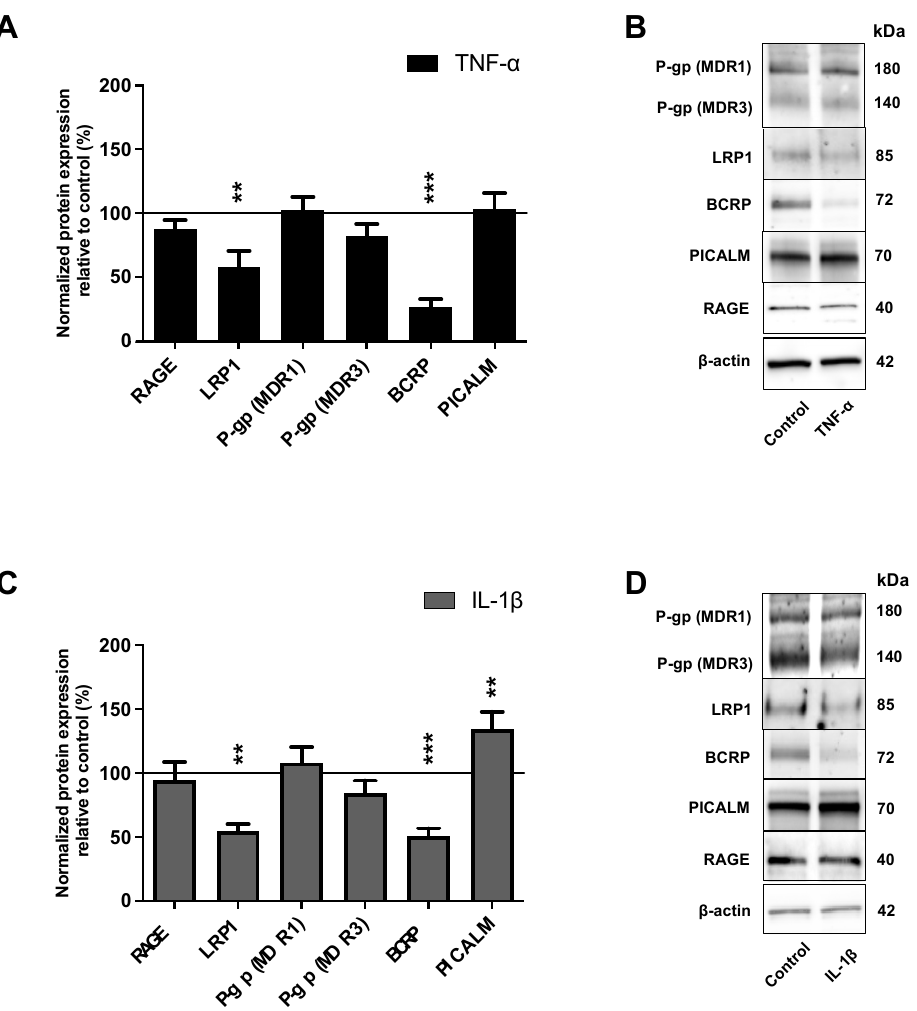
Figure 4. Impacts of TNF- α or IL-1 β treatments on the protein level of the actors involved in the A β peptide transport across BBB. After 24 h of 10 ng · mL − 1 ( A ) TNF- α or ( C ) IL-1 β treatments, the protein levels of the major actors involved in A β peptide transport at the BBB level (RAGE, LRP1, P-gp, BCRP and PICALM) were determined by Western immunoblotting. The black lines correspond to the control condition values (100%). Each bar represents the mean ± SEM relative to the control conditions. Each bar represents the mean ± SEM relative to the control conditions and is representa- tive of at least three independent experiments performed in triplicate. The Mann–Whitney t-test was used for the interpretation of statistical data with a threshold of statistical significance compared to the control condition set at ** p < 0.01; *** p < 0.001. ( B , D ) The immunoblotting images are repre- sentative of at least three independent experiments. RAGE: receptor for advanced glycation end- products; LRP1: Low-density lipoprotein receptor-related protein 1; P-gp: permeability-glycopro- tein; BCRP: breast cancer resistance protein; PICALM: phosphatidylinositol binding clathrin assem- bly protein. Treatment of BLECs with TNF- α or IL-1 β caused no significant change in RAGE and P-gp protein expression compared to the control (Figure 4A,C). Phosphatidylinositol binding clathrin assembly protein (PICALM) closely interacts with LRP1 and is involved in the transendothelial efflux of A β peptides from the brain to the blood [8]; we therefore also investigated the effects of proinflammatory cytokines on its expression. As observed in Figure 4A, TNF- α treatment did not affect PICALM protein expression, while IL-1 β treatment induced an increase of PICALM protein expression (Figure 4C).